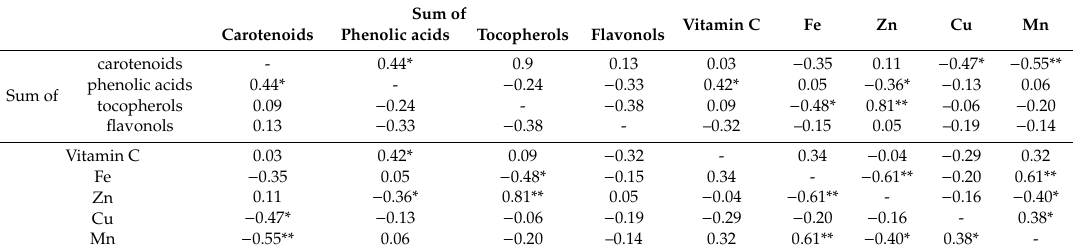
Table 7. Results of the correlation analysis between the contents of selected compounds with antioxidant properties in Cucurbita pepo